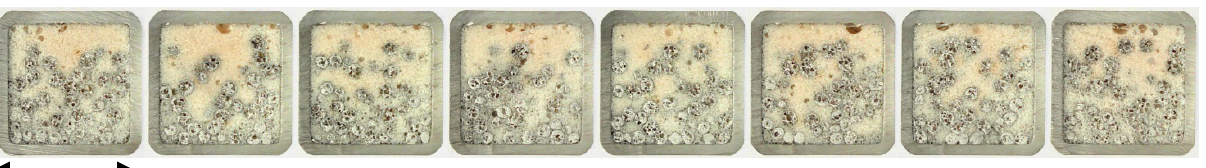
Figure 1. Hybrid APM foam filled tube cross sections.